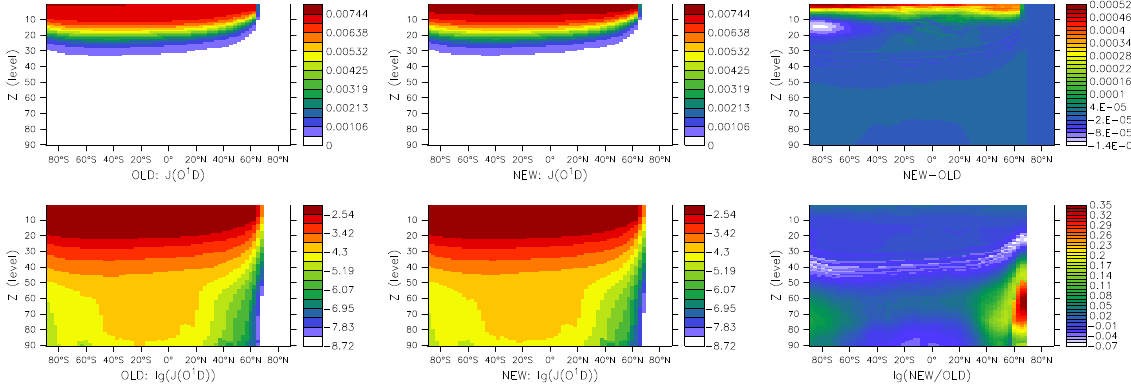
Figure 3. Comparison of the vertical profiles of the old and new J values (in s − 1 ) for O 3 → O( 1 D) , calculated for 2000-01-01, 02:00 UTC at a longitude of 138 ◦ E and 90 model levels (up to 0.01 hPa ). The first row is plotted on a linear scale, the second on a logarithmic scale. The left column shows the old result, the center column the new result, and the right column the differences.